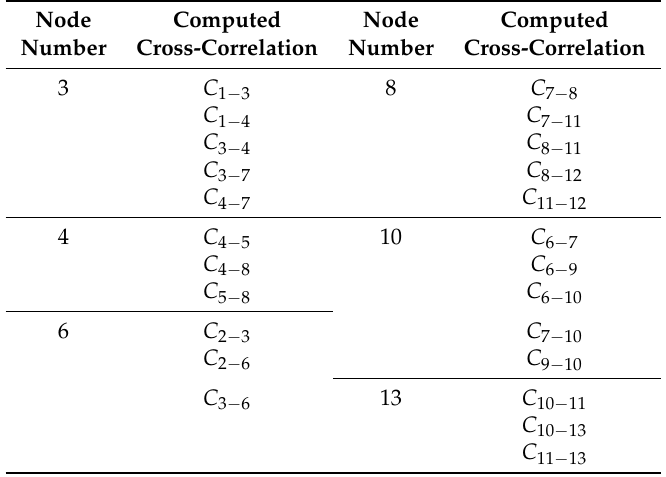
Table 6. Number of cross-correlations for each selected node (variable